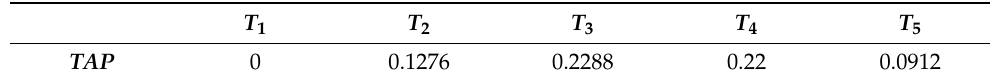
Table 6. Calculation of TAP for T 1 – T 5 .